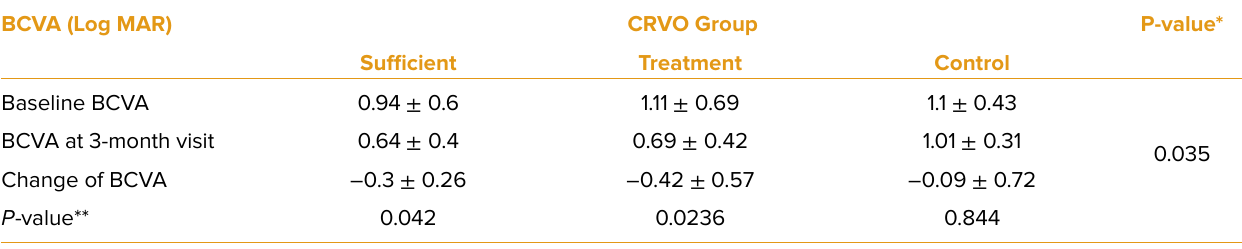
Table 6. Improvement of BCVA following three IVB injections in CRVO subgroups. BCVA (Log MAR) CRVO Group P-value* Sufficient Treatment Control Baseline BCVA 0.94 ± 0.6 1.11 ± 0.69 1.1 ± 0.43 0.035BCVA at 3-month visit 0.64 ± 0.4 0.69 ± 0.42 1.01 ± 0.31 Change of BCVA –0.3 ± 0.26 –0.42 ± 0.57 –0.09 ± 0.72 P -value** 0.042 0.0236